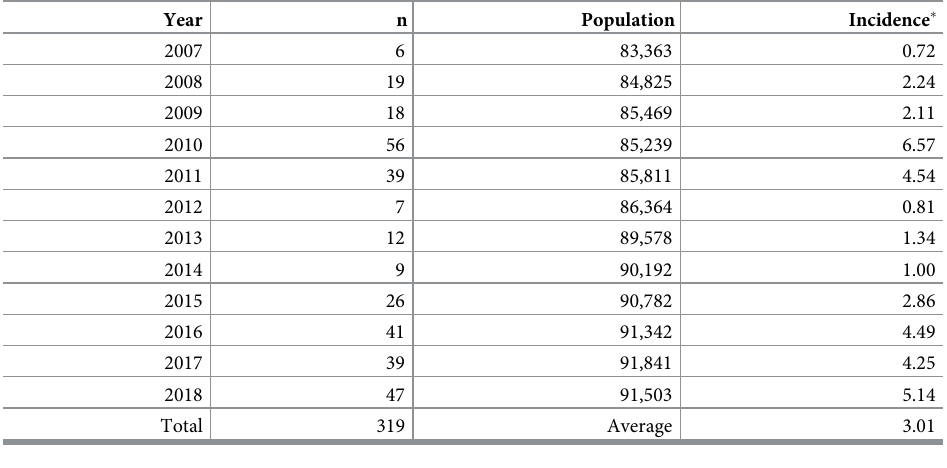
Table 2. Number of cases, population and incidence of ATL cases in the municipality of Caratinga